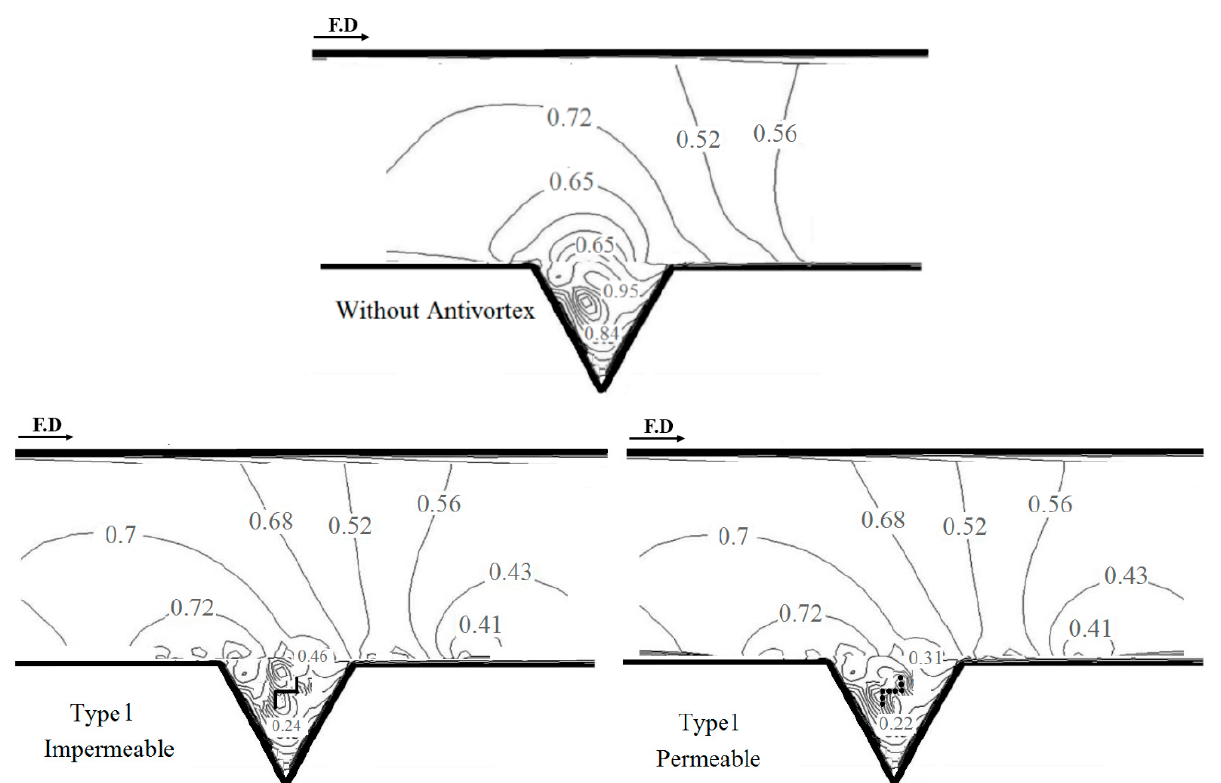
Figure 13. Longitudinal velocity contours in the main channel and around the antivortex structure.